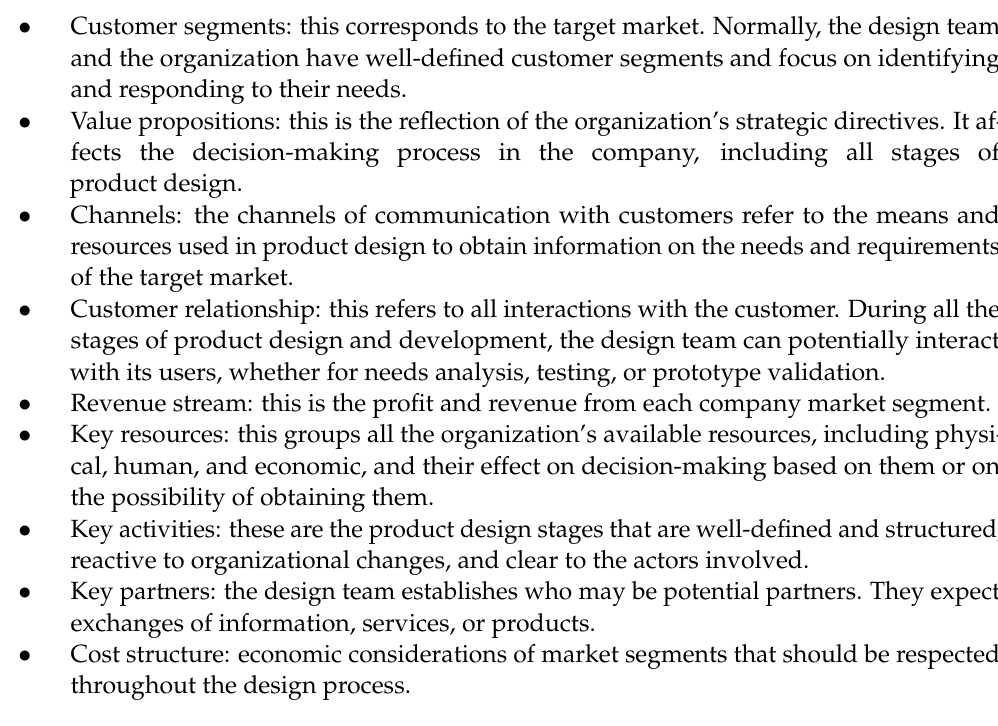
Figure 5. Data collection regarding involved actors.